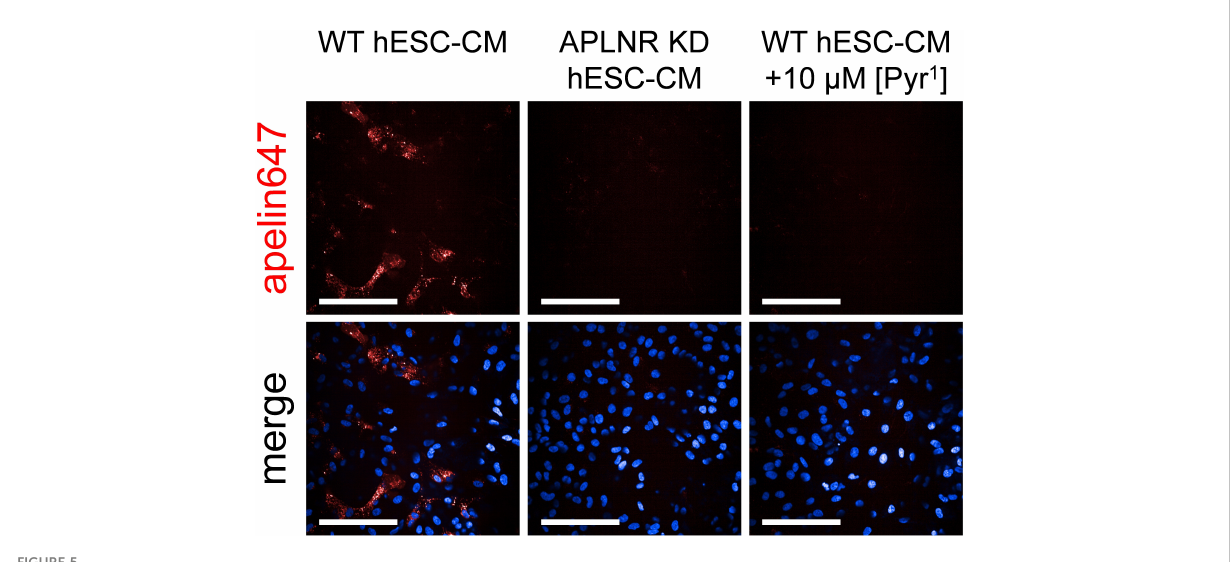
FIGURE 5 Representative confocal fl uorescent images of human embryonic stem cell-derived cardiomyocytes; either wild-type (WT hESC-CM) or apelin receptor knockdown (APLNR KD hESC-CM), treated with 300 nM apelin647 (visualised in red). Non-speci fi c binding was determined in WT hESC- CM cells treated with 300 nM apelin647, in the presence of a saturating 10 µM concentration of unlabelled [Pyr 1 ]apelin-13. Bottom row shows a merge with Hoechst 33342 nuclear marker (visualised in blue). n = 4 independent experiments using 4 distinct hESC-CM differentiations. Scale bars indicate 100